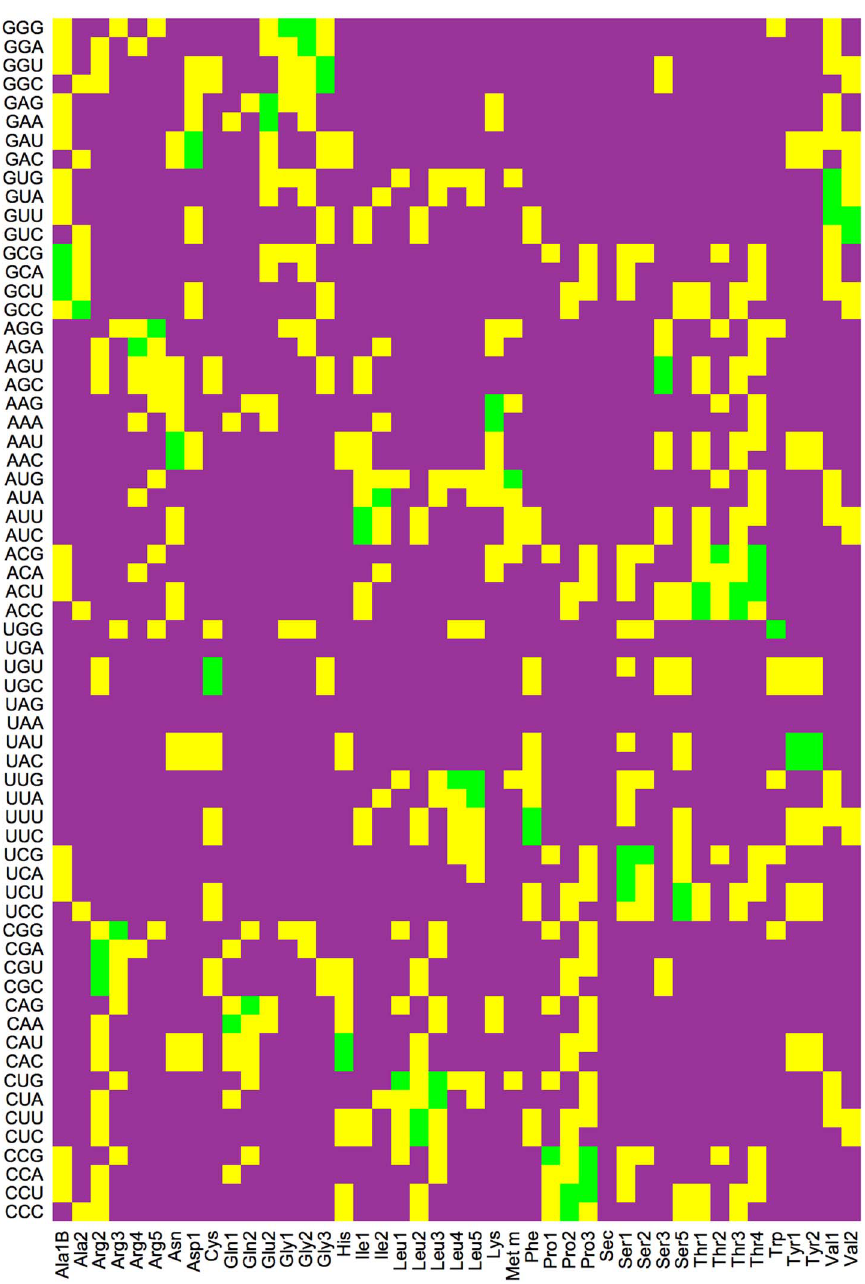
Figure 4. Decoding pattern arising from the cognate (green), near-cognate (yellow), and non-cognate (purple) relationships between all 61 sense codons and the 43 elongator tRNA species of E.coli as identified in Ref. [28]. For each tRNA species, the near- cognate codons differ from the cognate ones by a mismatch in one position of the codon-anticodon complex.